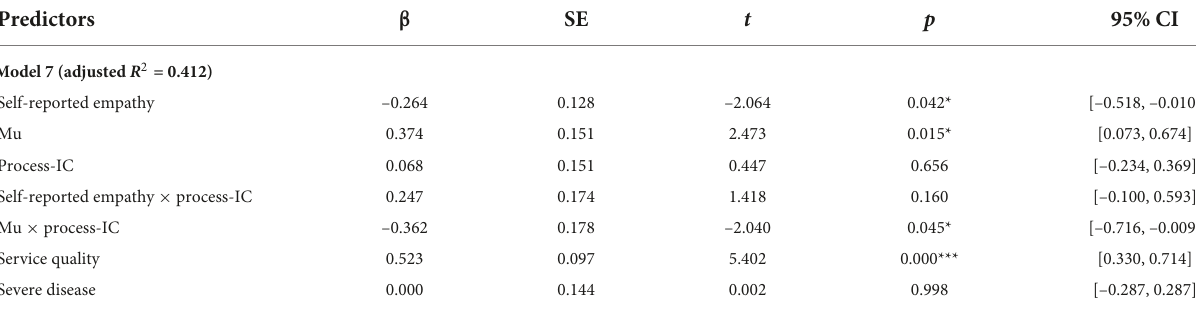
TABLE 4 Standardized coefficients of Model